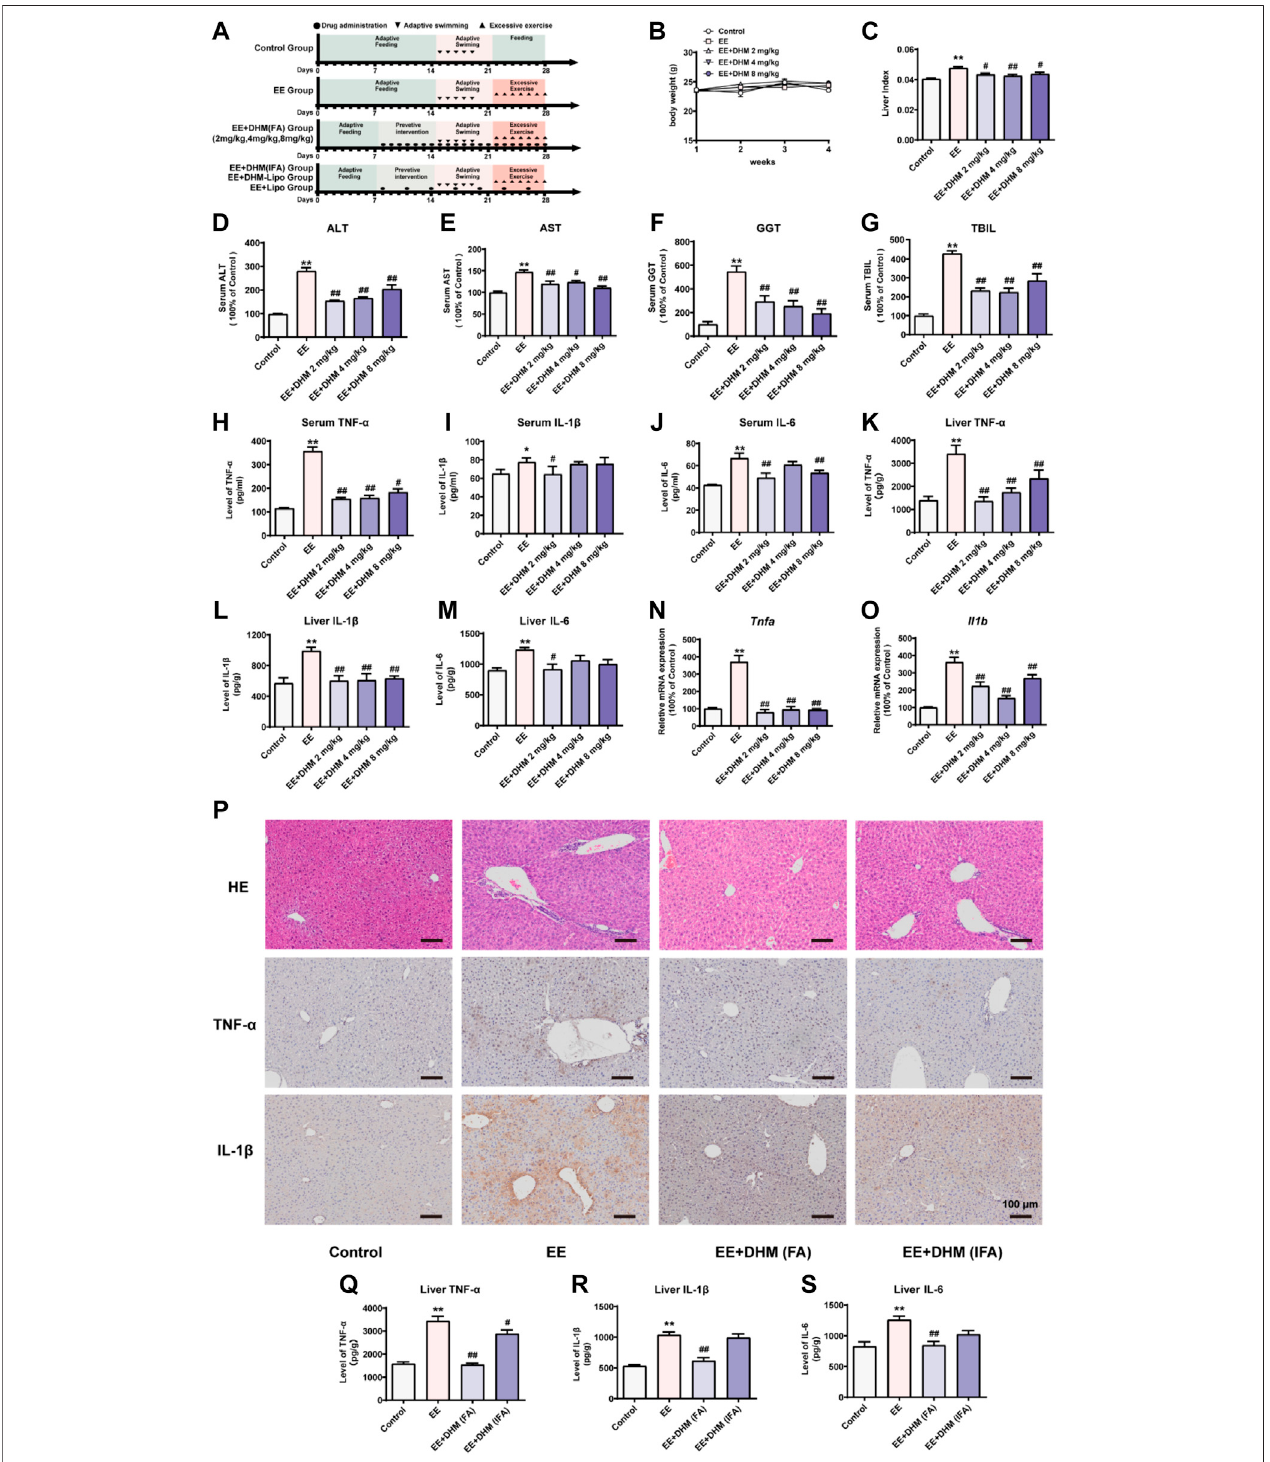
FIGURE 1 | DHM administration ameliorated EE-induced liver in fl ammation and its ef fi cacy was in fl uenced by the dosing interval (A) Schematic diagram of the experimental design (B) The body weights of the mice were recorded (C) The liver index represents the ratio of liver weight to body weight (D – G) Serum levels of ALT, AST,GGT,andTBILwereexamined (H-M) Theexpressionofthein fl ammatorycytokinesTNF- α ,IL-1 β ,andIL-6inmouseserumsamples (H – J) andmouseliversamples (K-M) was examined by ELISA (N-O) The mRNA expression levels of Tnfa and Il1b were detected by qRT – PCR (P) Liver in fl ammation was examined by H&E and IHC forTNF- α and IL-1 β (Q-S) Theexpression ofthein fl ammatorycytokines TNF- α ,IL-1 β , and IL-6in mouse liversampleswasexamined byELISA. Dataarepresented as the mean ± SEM ( n = 5). * p < 0.05, ** p < 0.01, compared to the control group; # p < 0.05, ## p < 0.01, compared to the EE group. Scale bar, 100 μ m.